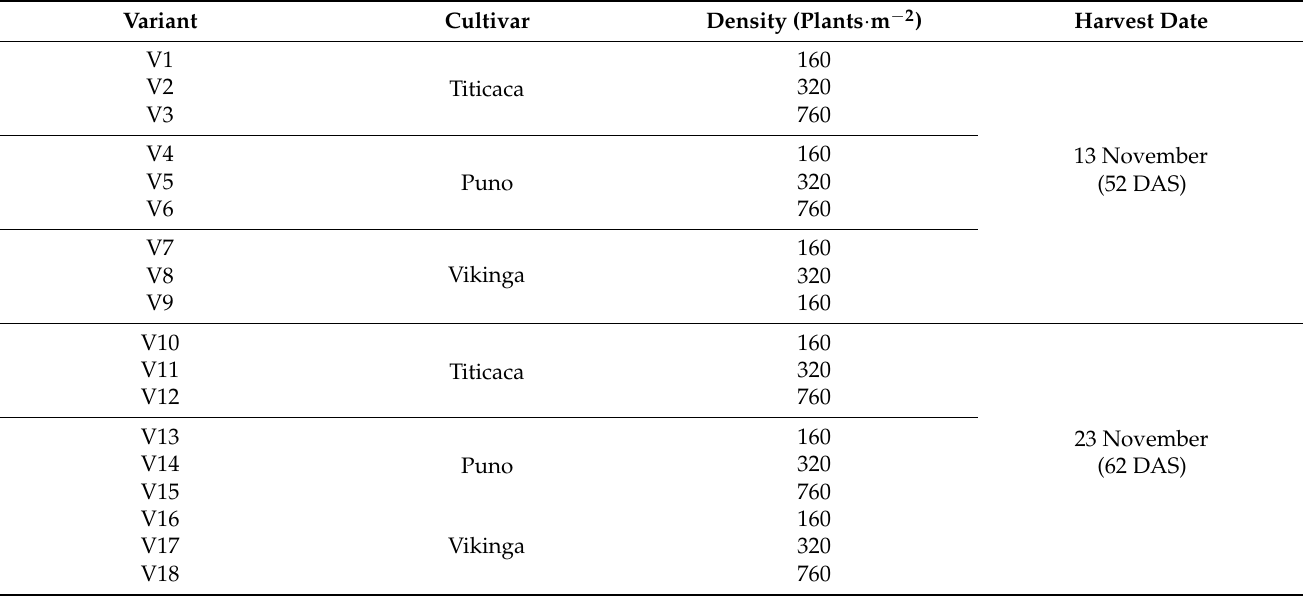
Table 2. Experimental plot